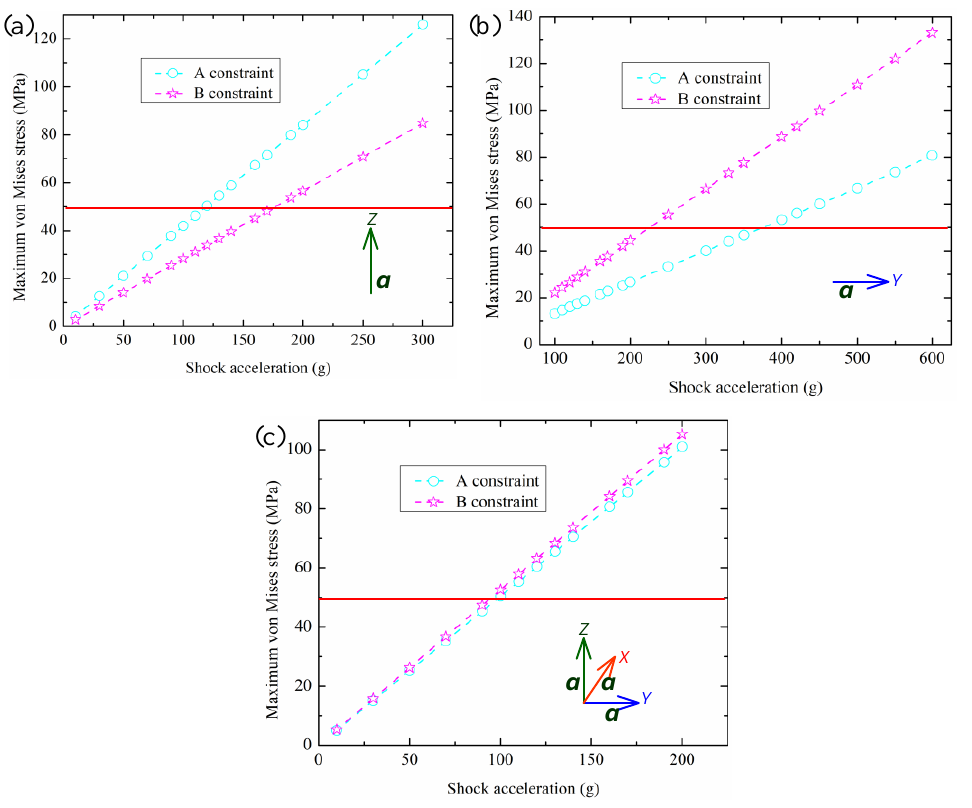
Figure 5. Variation of σ von-Mises as a function of the shock acceleration and the constraint position of the holes used to fix the cavity as well as the loading along the three directions: ( a ) Vertical direction ( Z -axis). ( b ) Horizontal direction ( Y -axis). ( c ) Three orthogonal directions ( X -axis, Y -axis, and Z -axis). (Figure 1). The cyan dashed line with circles and the magenta dashed line with stars represent σ von-Mises corresponding to constraints A and B, respectively. The red line represents the ultimate tensile stress σ max of the material ULE of the USOC.